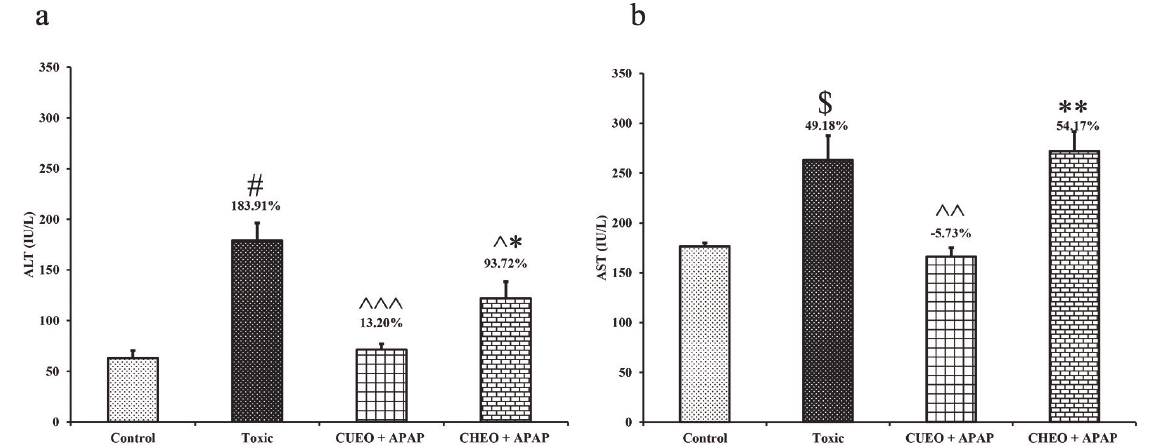
Figure 1 - Effects of 2-week treatment with CUEO or CHEO on serum ALT ( a ) and AST ( b ) levels 24 hours after acute APAP administration. Control = 1% Tween 80 (p.o. for 14 days), Toxic = 1% Tween 80 (p . o. for 14 days) and APAP (acetaminophen: 1g/kg, p . o . on Day 14), CUEO = cumin essential oil (400 mg/kg/day, p.o. for 14 days), CHEO = chamomile essential oil (250 mg/